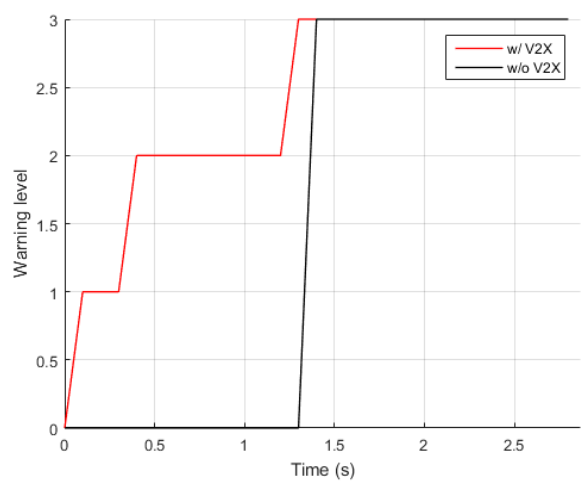
Figure 12. Collision warning generated over time in the vehicle–pedestrian collision scenario.